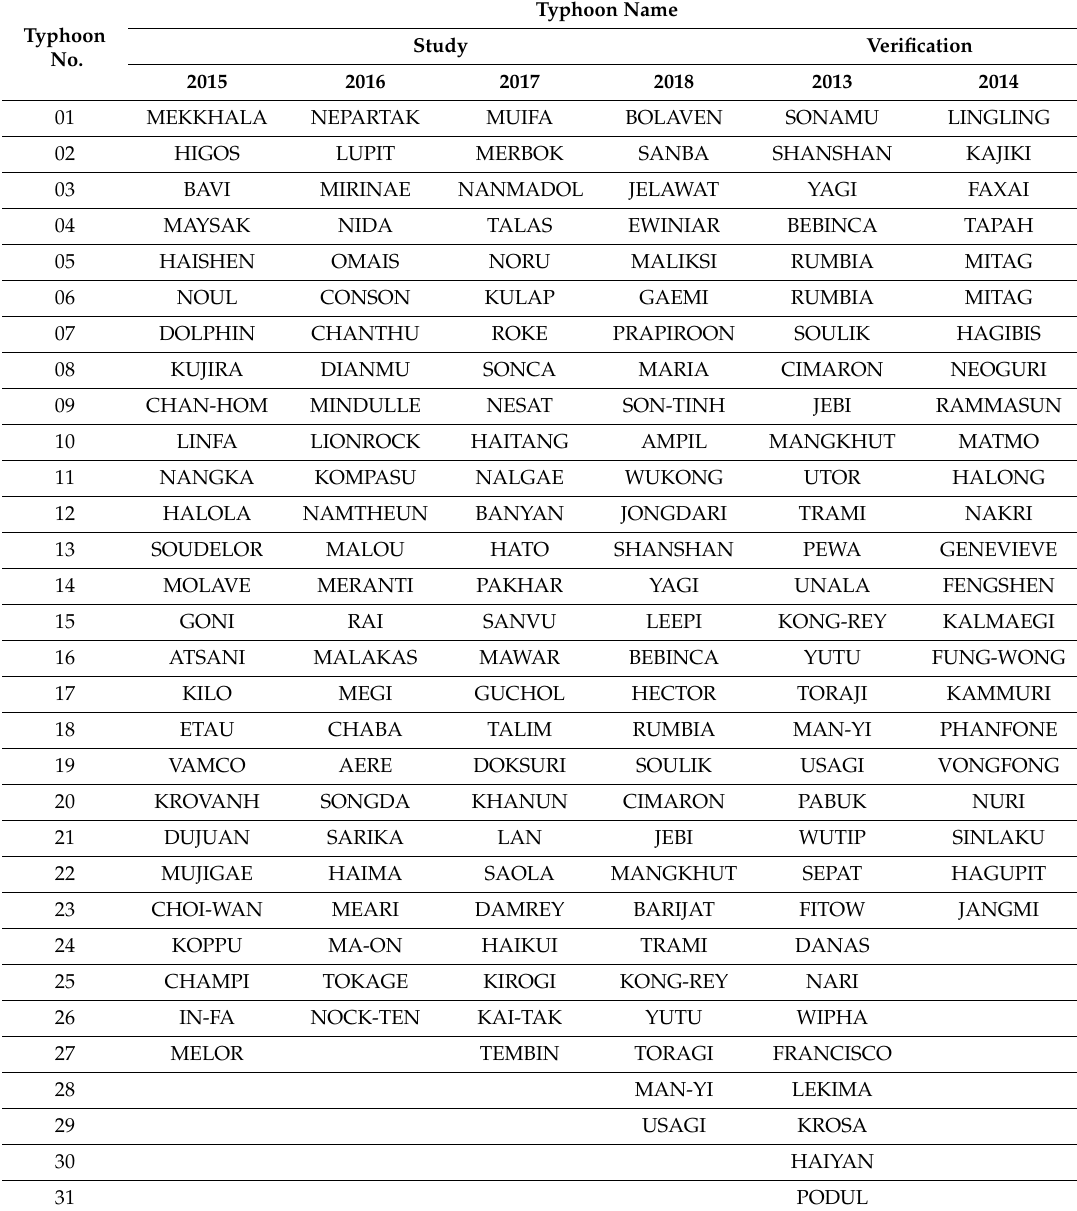
Table 1. List of northwestern Pacific tropical cyclones (TCs) during the study period. Typhoon